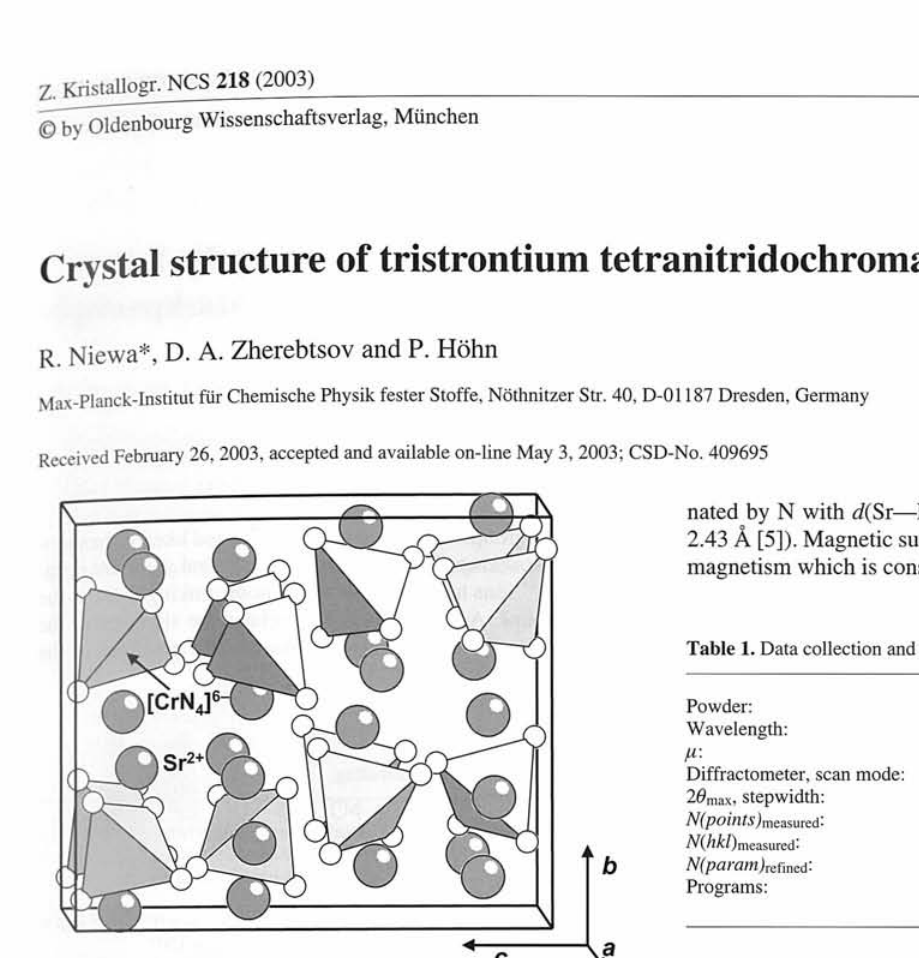
Table 2. Atomic coordinates and displacement parameters (in